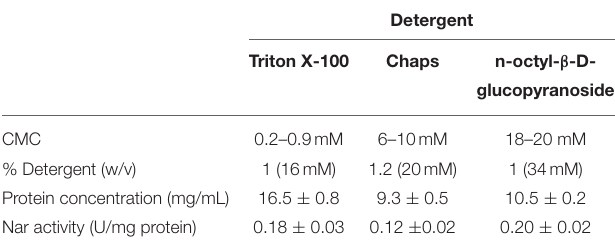
TABLE 1 | Parameters of the different detergents tested for the formation of micelles from crude extract: CMC (critical micelle concentration); % detergent (w/v); protein concentration (mg/mL); nitrate reductase specific activity